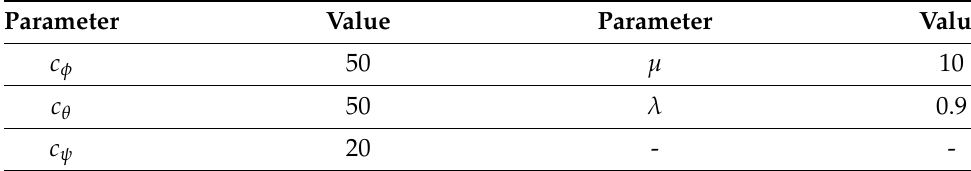
Table 2. Control parameters.